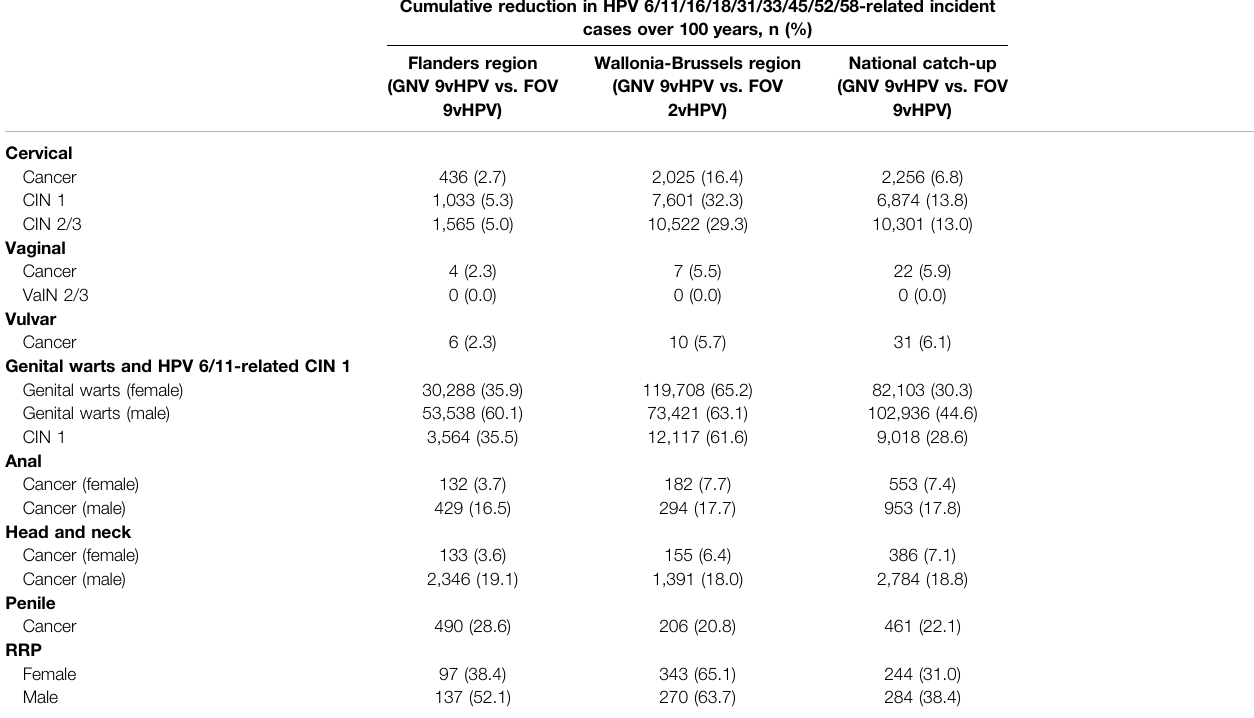
TABLE 5 | Cumulative reduction in HPV 6/11/16/18/31/33/45/52/58-related disease incidence for gender-neutral vaccination with the 9vHPV vaccine compared with 9vHPVvaccination in femalesonly in theFlandersRegion, 2vHPVVaccinationin Females Only in theWallonia-Brusselsregions, and 9vHPVVaccinationinFemalesOnly nationwide in Belgium over 100 years.